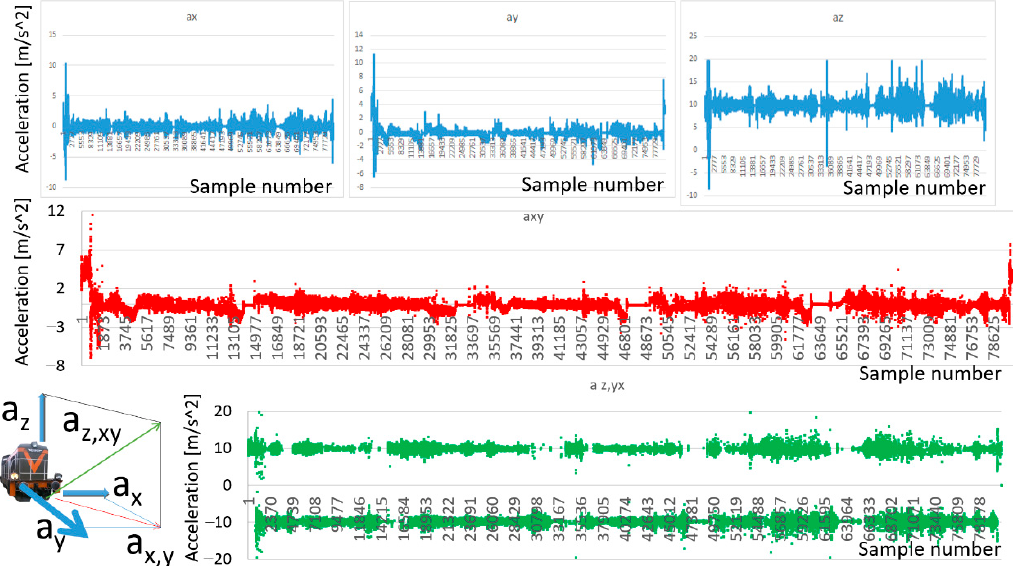
Figure 12. The resultant vectors of accelerations: Source: authors’ own materials.